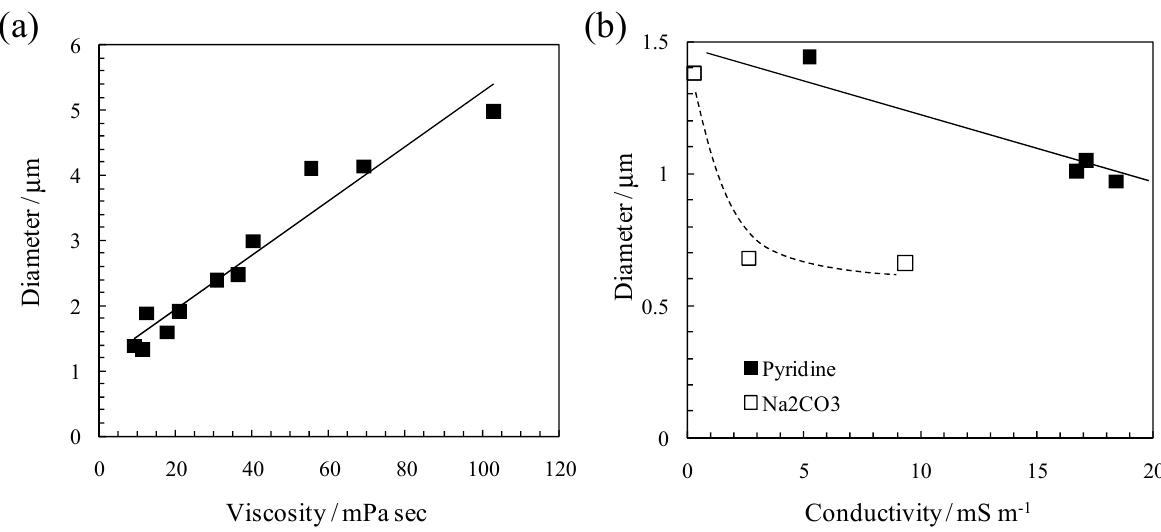
Figure 2. ( a ) Effect of solution viscosity on the diameters of the electrospun phenolic-resin fibers. Solution viscosity was changed by polymer concentration. ( b ) Effect of solution conductivity on diameters of the electrospun phenolic-resin fibers. Additives to the spinning solution are pyridine and sodium carbonate (Adapted from